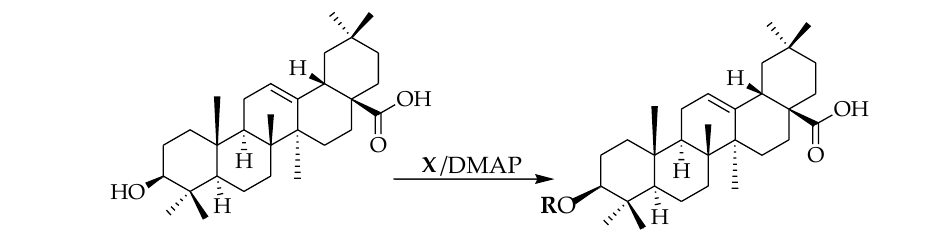
Figure 6. Modification of OA. Table 2. Synthesis of oleanolic acid.